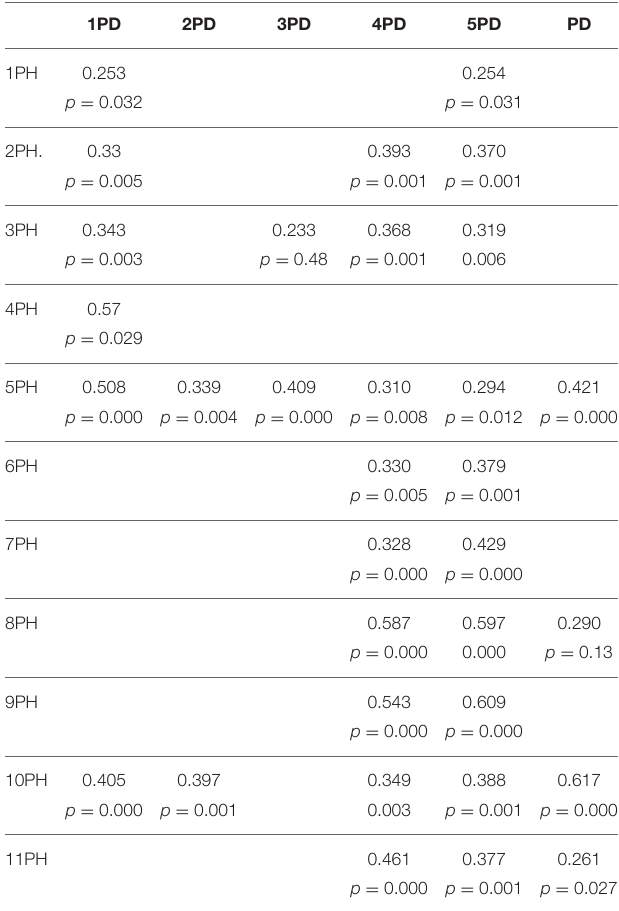
TABLE 6 | Determinants of the main dimensions of the hallucination—linear regression.